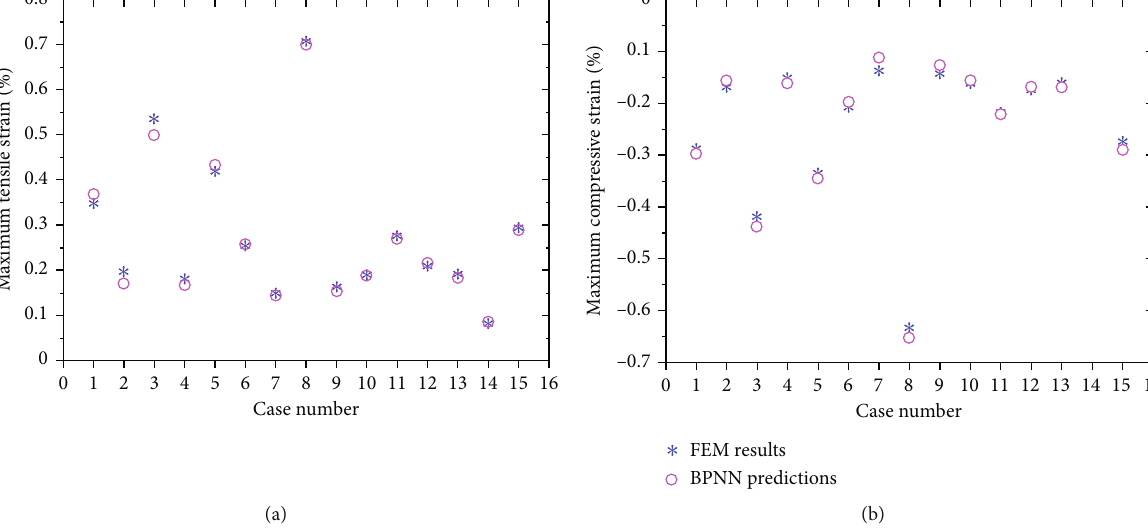
Figure 18: Comparison results of longitudinal strains between the predictions of BPNN and FEM: (a) maximum tensile strain and (b) maximum compressive strain.